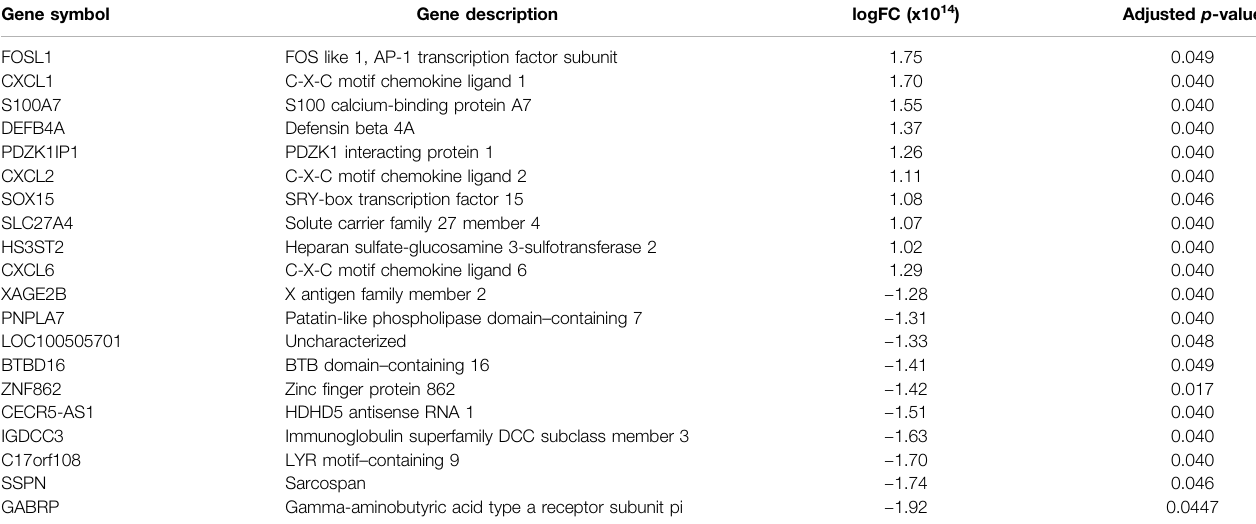
TABLE1| ToptengenesupregulatedanddownregulatedshowingalteredexpressioninhPLF-hTERTcomparedtotheprimarycellcultureofhPLF.Genefoldregulationand p -value are reported for each gene.